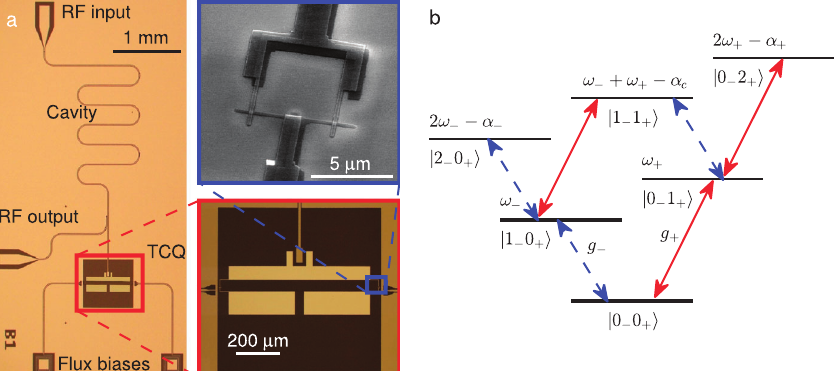
Fig. 1 TCQ device and its energy levels. a Optical micrographs show a TCQ coupled to the end of a readout cavity. RF input and output ports are coupled capacitively to the cavity and spiral inductors are used as low pass fi lters for the DC bias lines. Electron micrograph shows two Josephson junctions forming a SQUID loop of size ≈ 5 × 5 μ m 2 . b V-shaped energy diagram up to two qubit excitations. Red solid and blue dashed lines indicate transitions with dipole coupling rates g + and g − , respectively